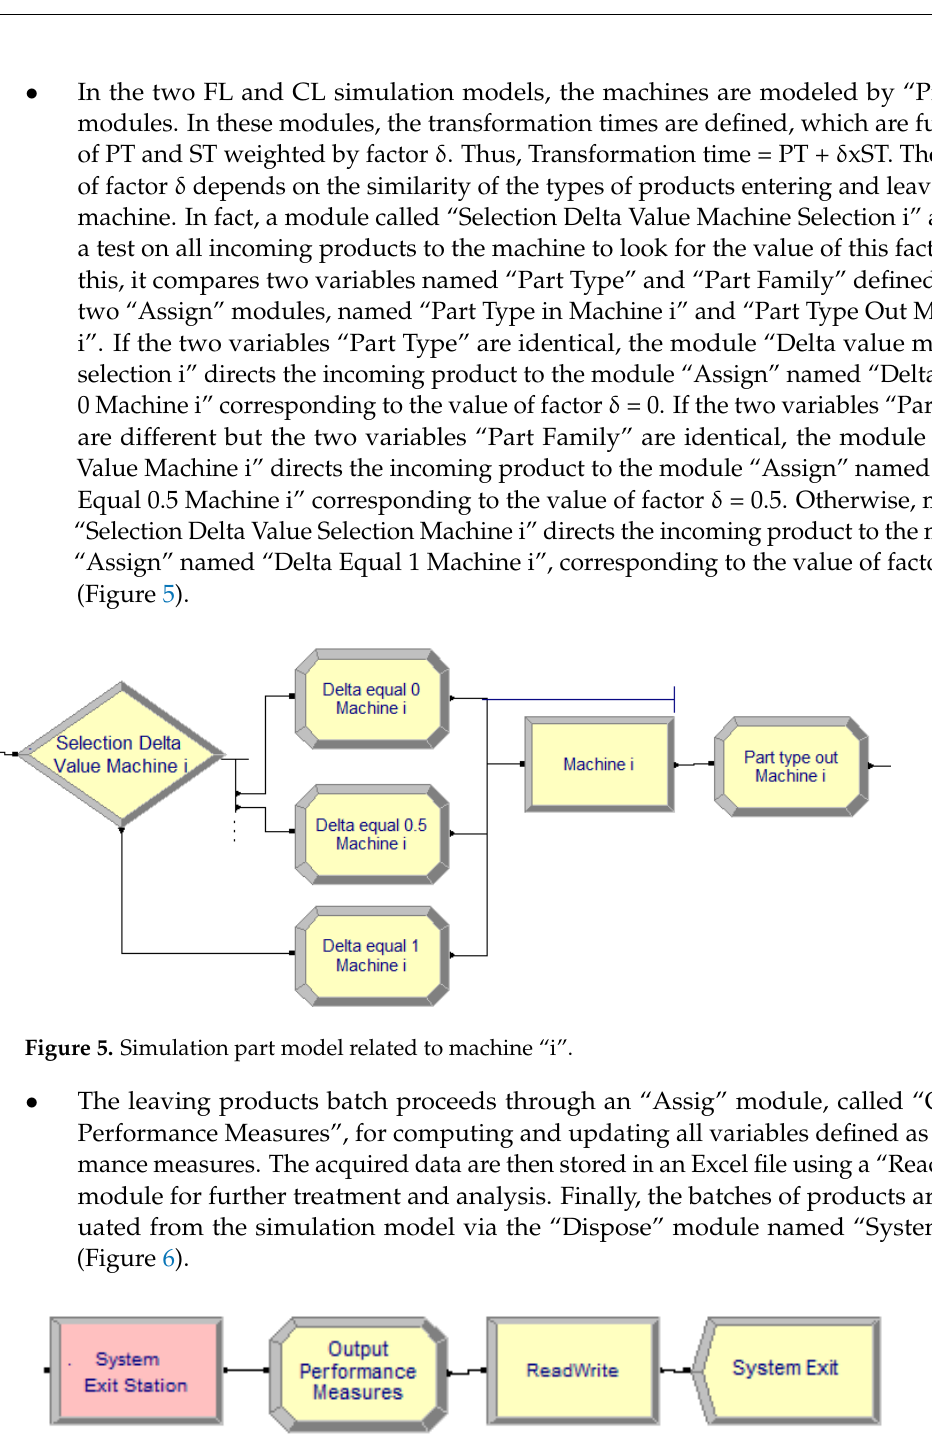
Figure 6. Simulation part model related to system exit.